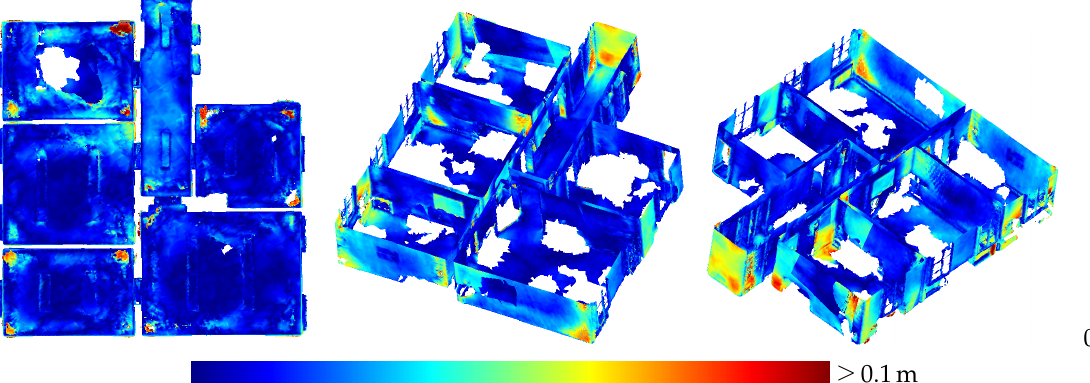
Figure 17. Accuracy of the HoloLens triangle mesh evaluated against the TLS ground truth. The registration was done with fixed scale. The mean distance to the ground truth amounts to 2.3cm.